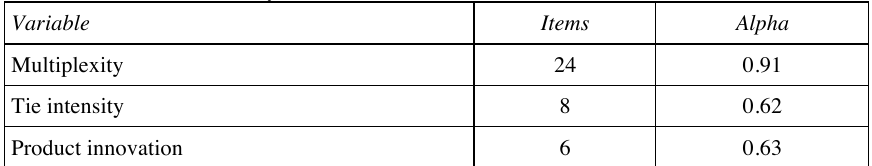
Table 1. Instrument